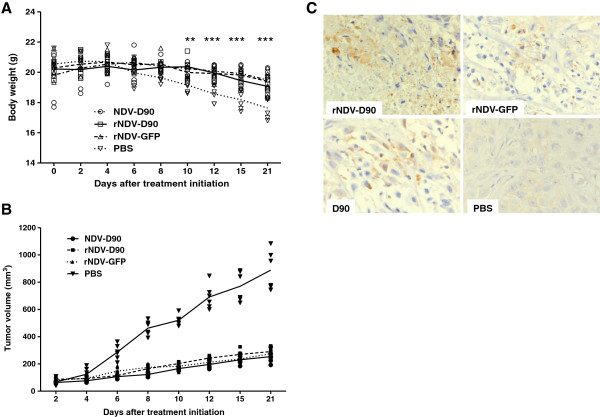
Treatment of A549 tumor-bearing nude mice with recombinant viruses. Female athymic mice bearing A549 cell tumors were treated with the parental D90, rNDV-D90 or rNDV-GFP (107 TCID50/mouse) by intratumoral injections. PBS-treated mice were taken as controls. (A) Body weights were monitored. **P < 0.01, ***P < 0.001. (B) Tumor volume was measured and recorded. (C) Immunohistochemical staining of cleaved caspase-3 in tumor sections from the tumor-bearing mice.